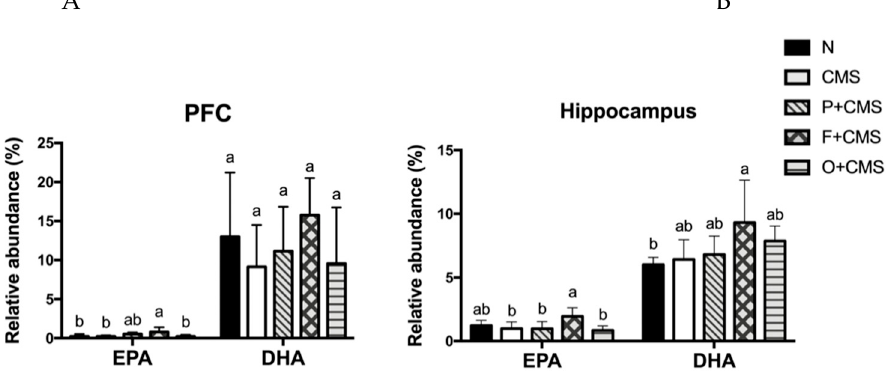
Figure 4. Percentages of eicosapentaenoic acid (EPA) and docosahexaenoic acid (DHA) in the ( A ) prefrontal cortex (PFC) and ( B ) hippocampus. Data are expressed as mean ± SD (n = 8 or 9 per group). Values with different superscript letters are significantly different at p < 0.05.